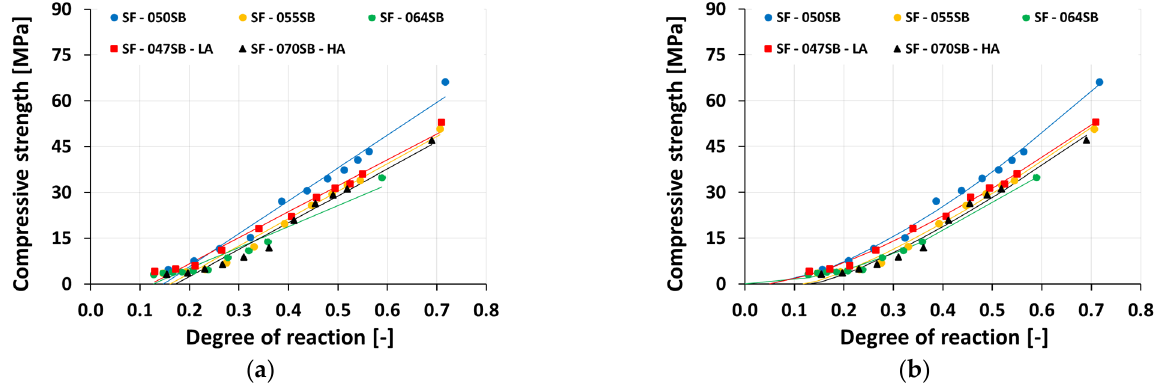
Figure 11. Compressive strength evolution as a function of the degrees of reaction: ( a ) linear fit; ( b ) power-law fit. Table 8. Parameters of the fitting function, Equations (5) and (6), for the compressive strength evo- lution as a function of the degree of reaction.